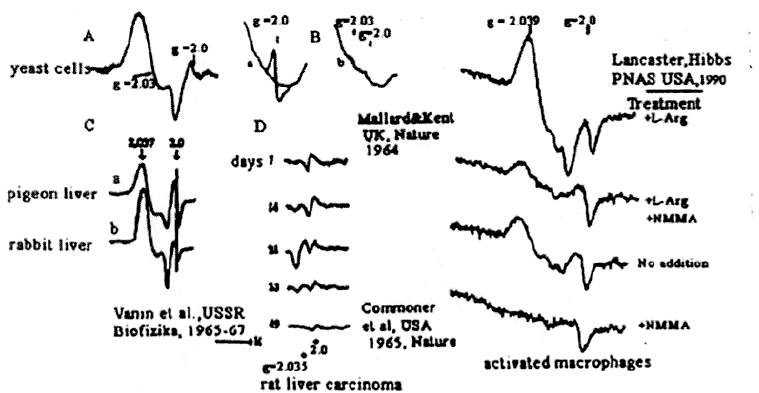
Figure 5. The 2.03 signals recorded in the 1960s in: ( A ) yeast cells; ( B (a,b)) control liver preparation and chemically induced rat hepatoma tissue, respectively; ( C (a,b)) pigeon and rabbit livers, respectively; ( D ) chemically induced rat hepatoma at different periods following treatment of rats with hepatocarcinogenic agents. Right panel: The 2.03 signals recorded in 1990 in activated rat macrophages in the presence of L-arginine, L-arginine + N -methyl-L-arginine, in the absence of L-arginine + N -methyl-L-arginine and in the presence of N -methyl-L-arginine alone [22].